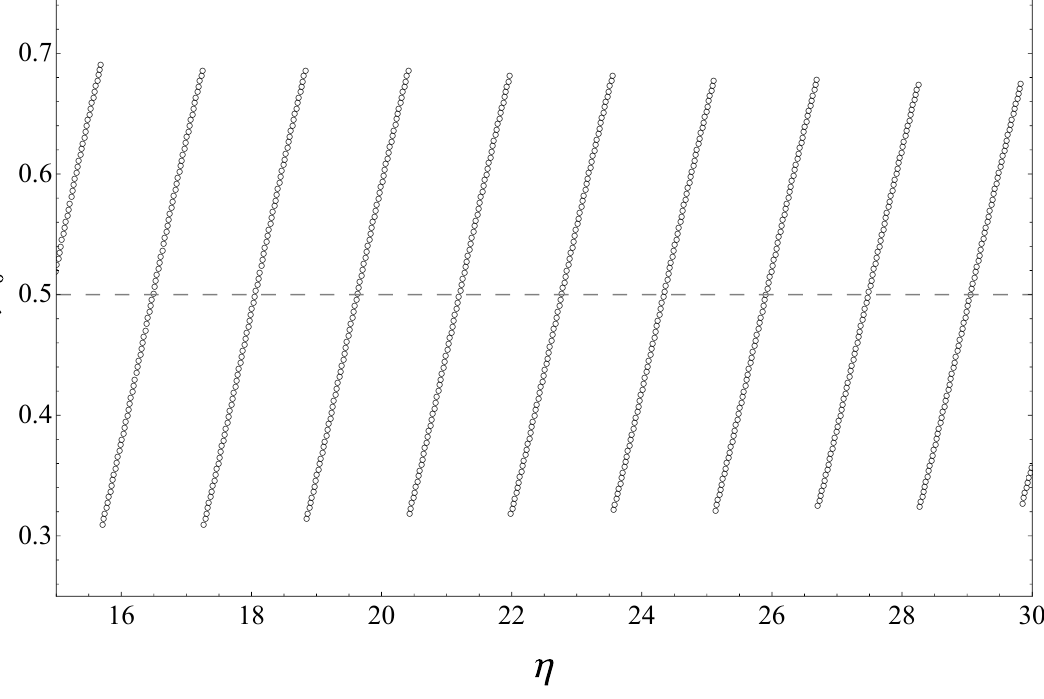
corresponding to the critical index (3.10) in terms of η 0